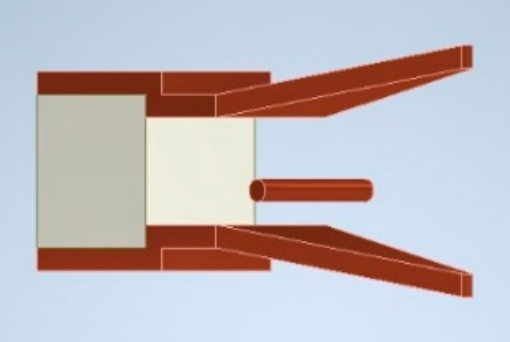
Figure 11. CAD of Spark Plug with the electrodes.